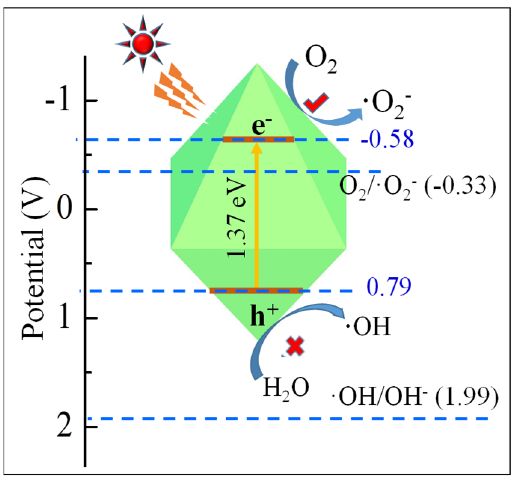
Figure 8. Photocatalytic mechanism of MnS for TCH removal. SEM images (Figure 9A–C) indicated that the morphology of used MnS after five cycles was not obviously affected in comparison to fresh samples (Figure 2D–F). However, the photo-corrosion seriously influenced the valence states of adsorbed and to-catalyzed MnS. For comparison to fresh sample, the peaks of Mn 2p1/2 and Mn 2p3/2 of Mn 2+ in adsorbed MnS shifted to 652.05 and 640.42 eV, and its corresponding satellite peaks changed to 654.02 and 643.66 eV, respectively (Figure 9D) [33,35]. The split peaks of Mn 2p in photo-catalyzed MnS shifted to the lower binding energies. In addition, the S